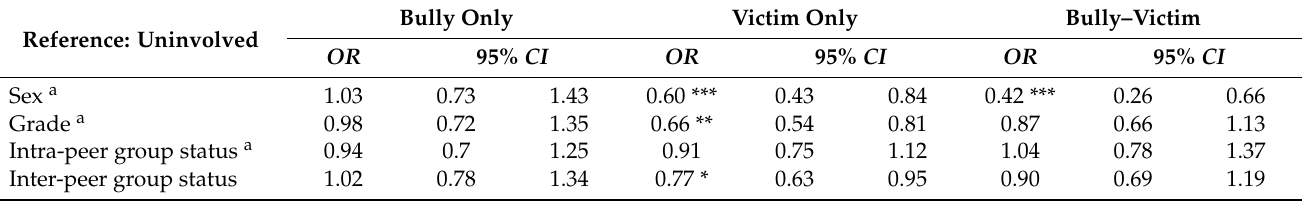
Table 2. Multinomial logistic regression for the four sub-categories of school bullying ( n =